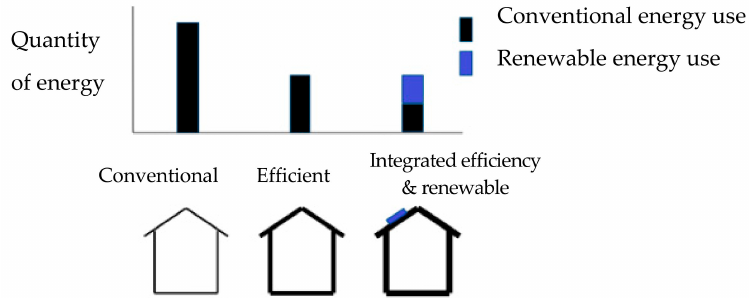
Figure 9. Demonstration of how combining energy efficiency and RE strategies significantly reduces total building conventional energy use [61]. National Renewable Energy